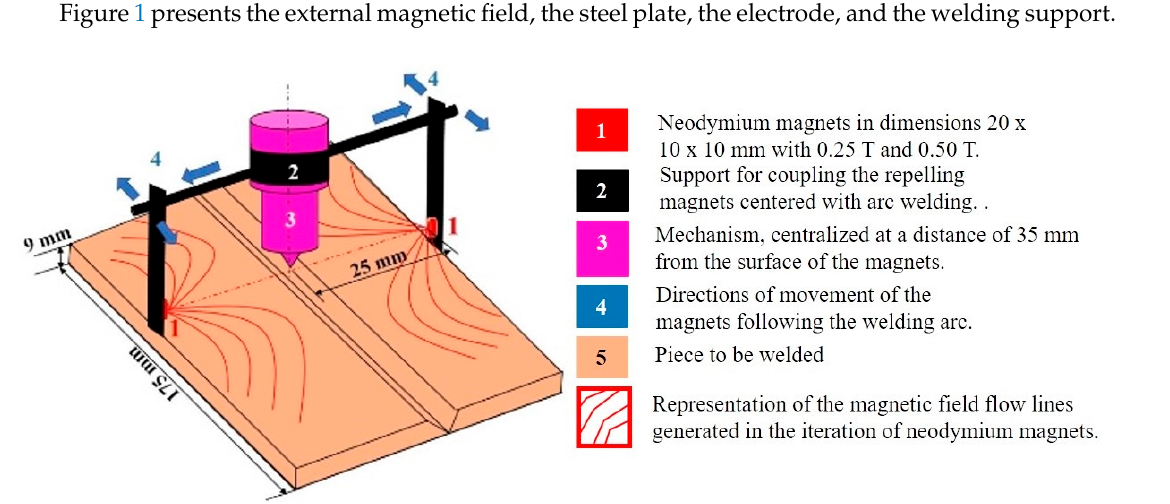
Figure 1. Schematic illustration of the welding process with the addition of the external magnetic field.